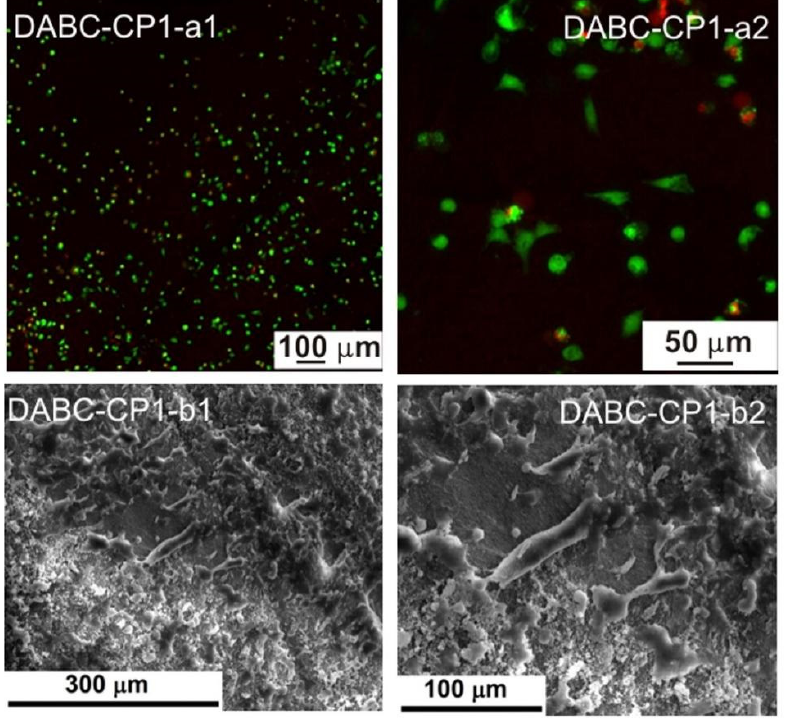
Figure 12. Fluorescence microscopy images ( a1 , a2 ) and SEM images ( b1 , b2 ) of the adherent cells in a DABC sample.